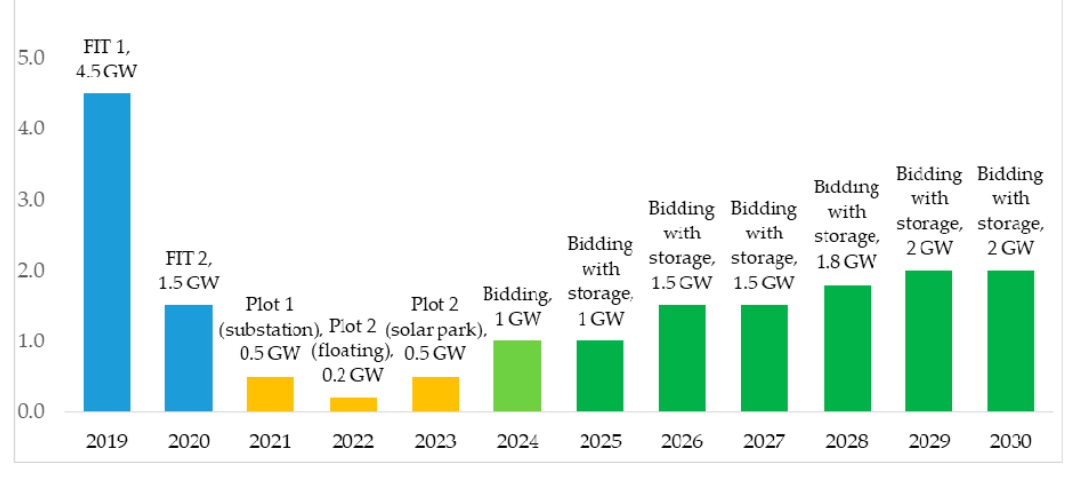
Figure 13. Solar deployment per year of COD.